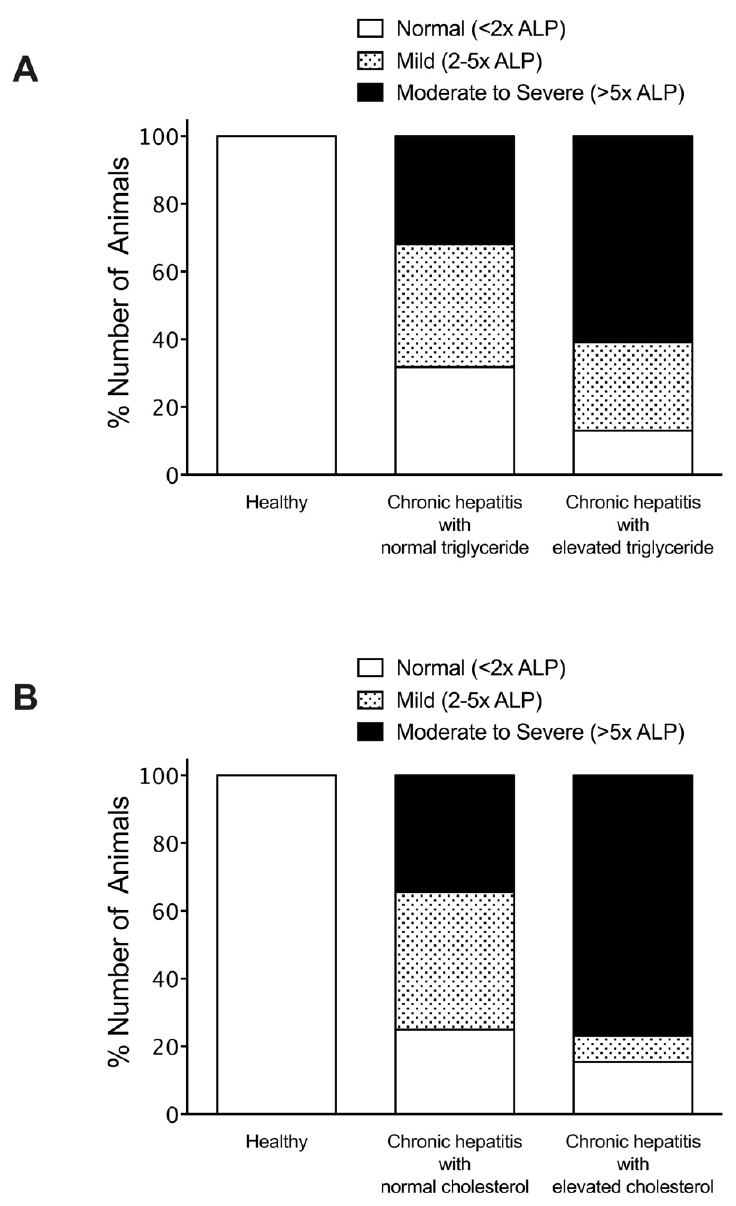
Figure 3. Histogram illustrating serum ALP concentrations of healthy and dogs with chronic hepatitis, classified by triglyceride levels ( A ) or cholesterol levels ( B ). The magnitude of serum ALP concentration was divided into normal, mild, and moderate to severe .